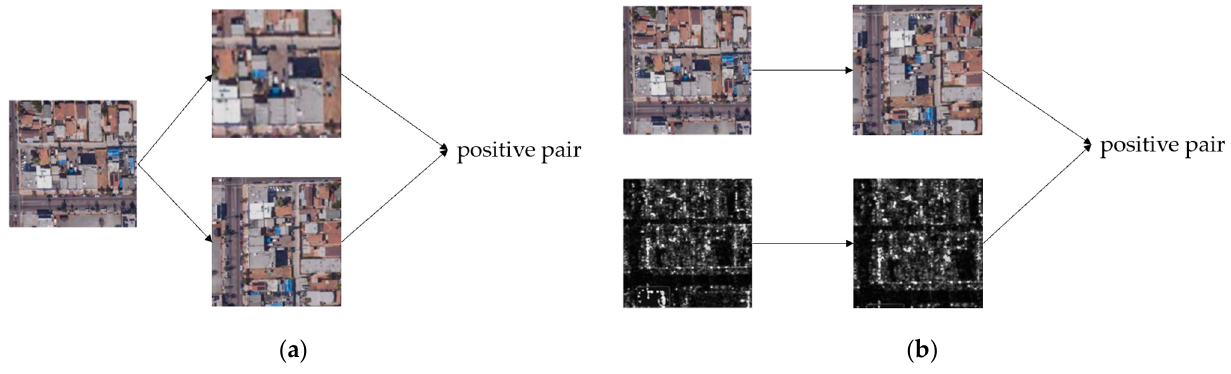
Figure 2. Schematic diagram of positive pair: ( a ) single-source augmentation; ( b ) SAR-optical aug- mentation.